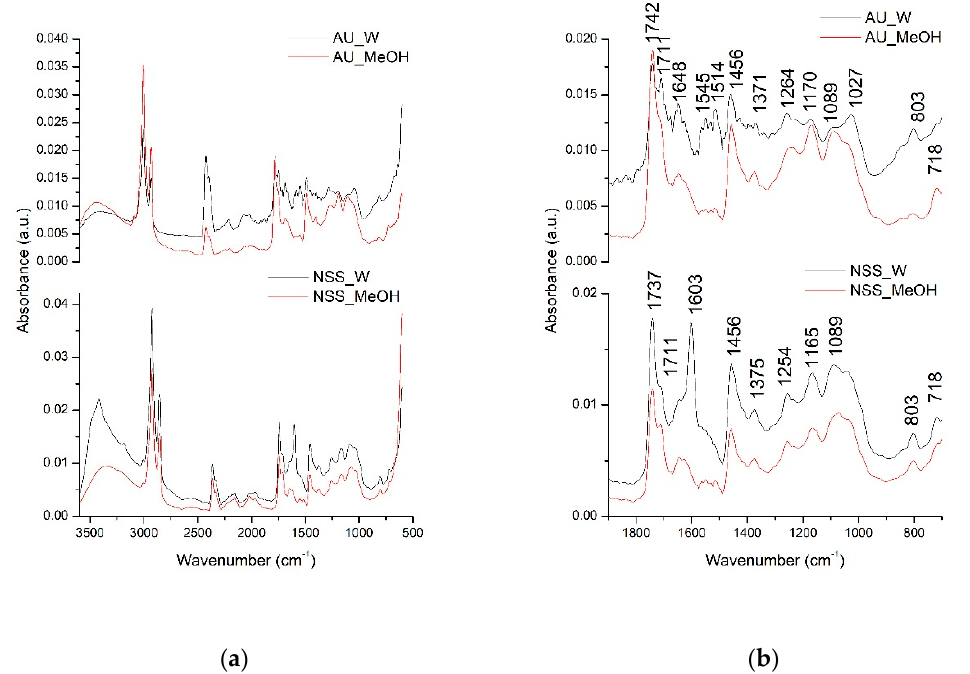
Figure 1. Allium ursinum (A.U)- and Nigella sativa seed (NSS) general FTIR spectra (500–3500 cm − 1 ) ( a ) and fingerprint region (800–1800 cm − 1 ) ( b ).